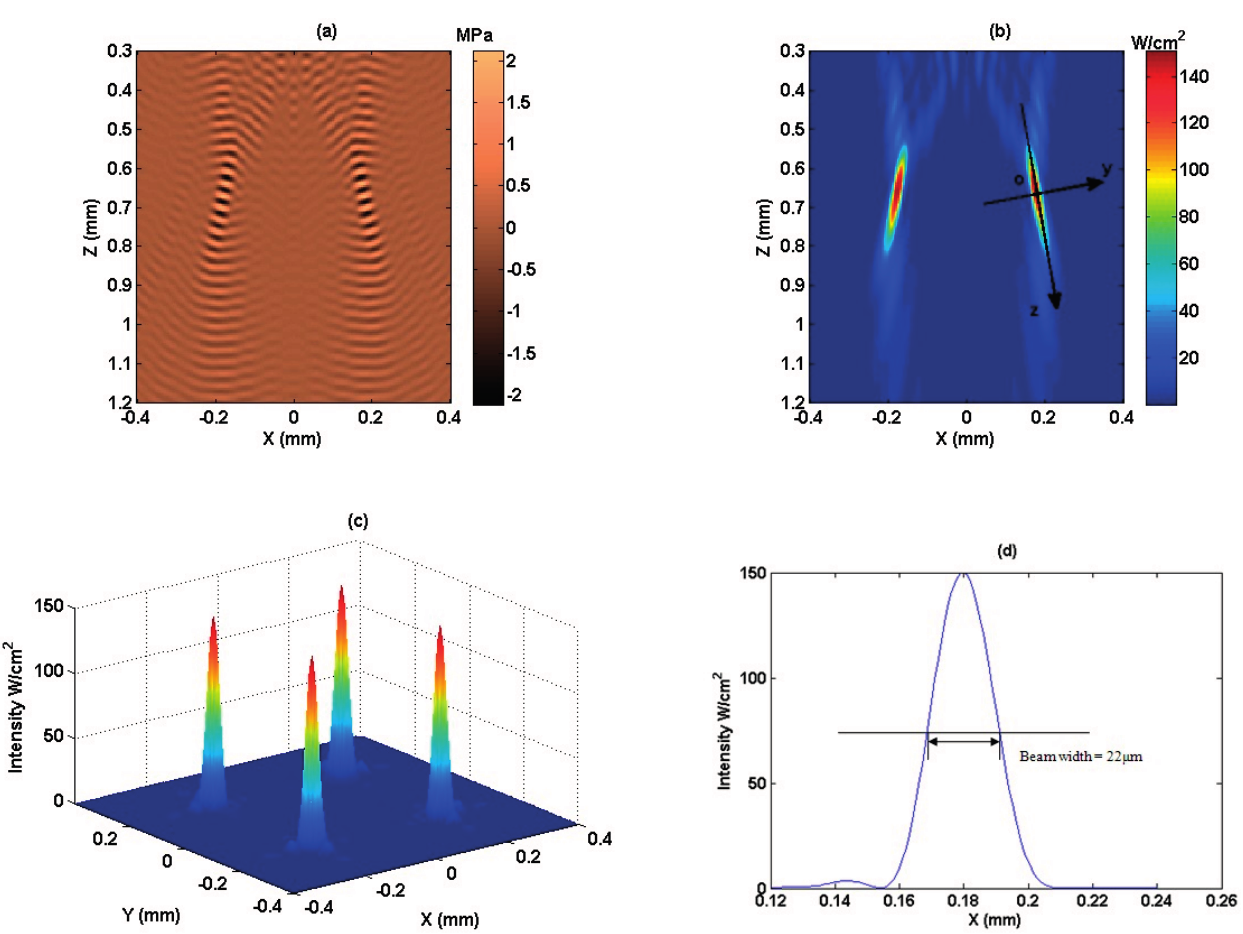
Figure 5. Acoustic intensity field for four focus points. ( a ) Instantaneous pressure field along the beam axis; ( b ) Acoustic intensity field along the beam axis; ( c ) Acoustic intensity field across the z -axis; ( d ) Intensity profile for one of the four focal points across the beam axis and passing through the focal